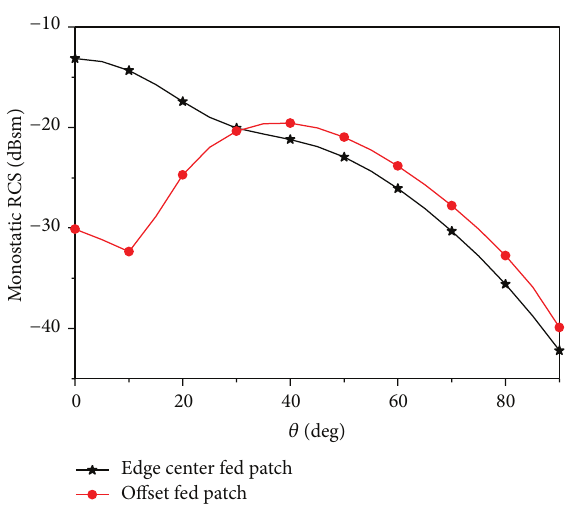
Figure 5: Monostatic in-band RCS of the edge center fed antenna ( 𝑓 = 4.319 GHz) and offset fed antenna ( 𝑓 = 4.163 GHz).